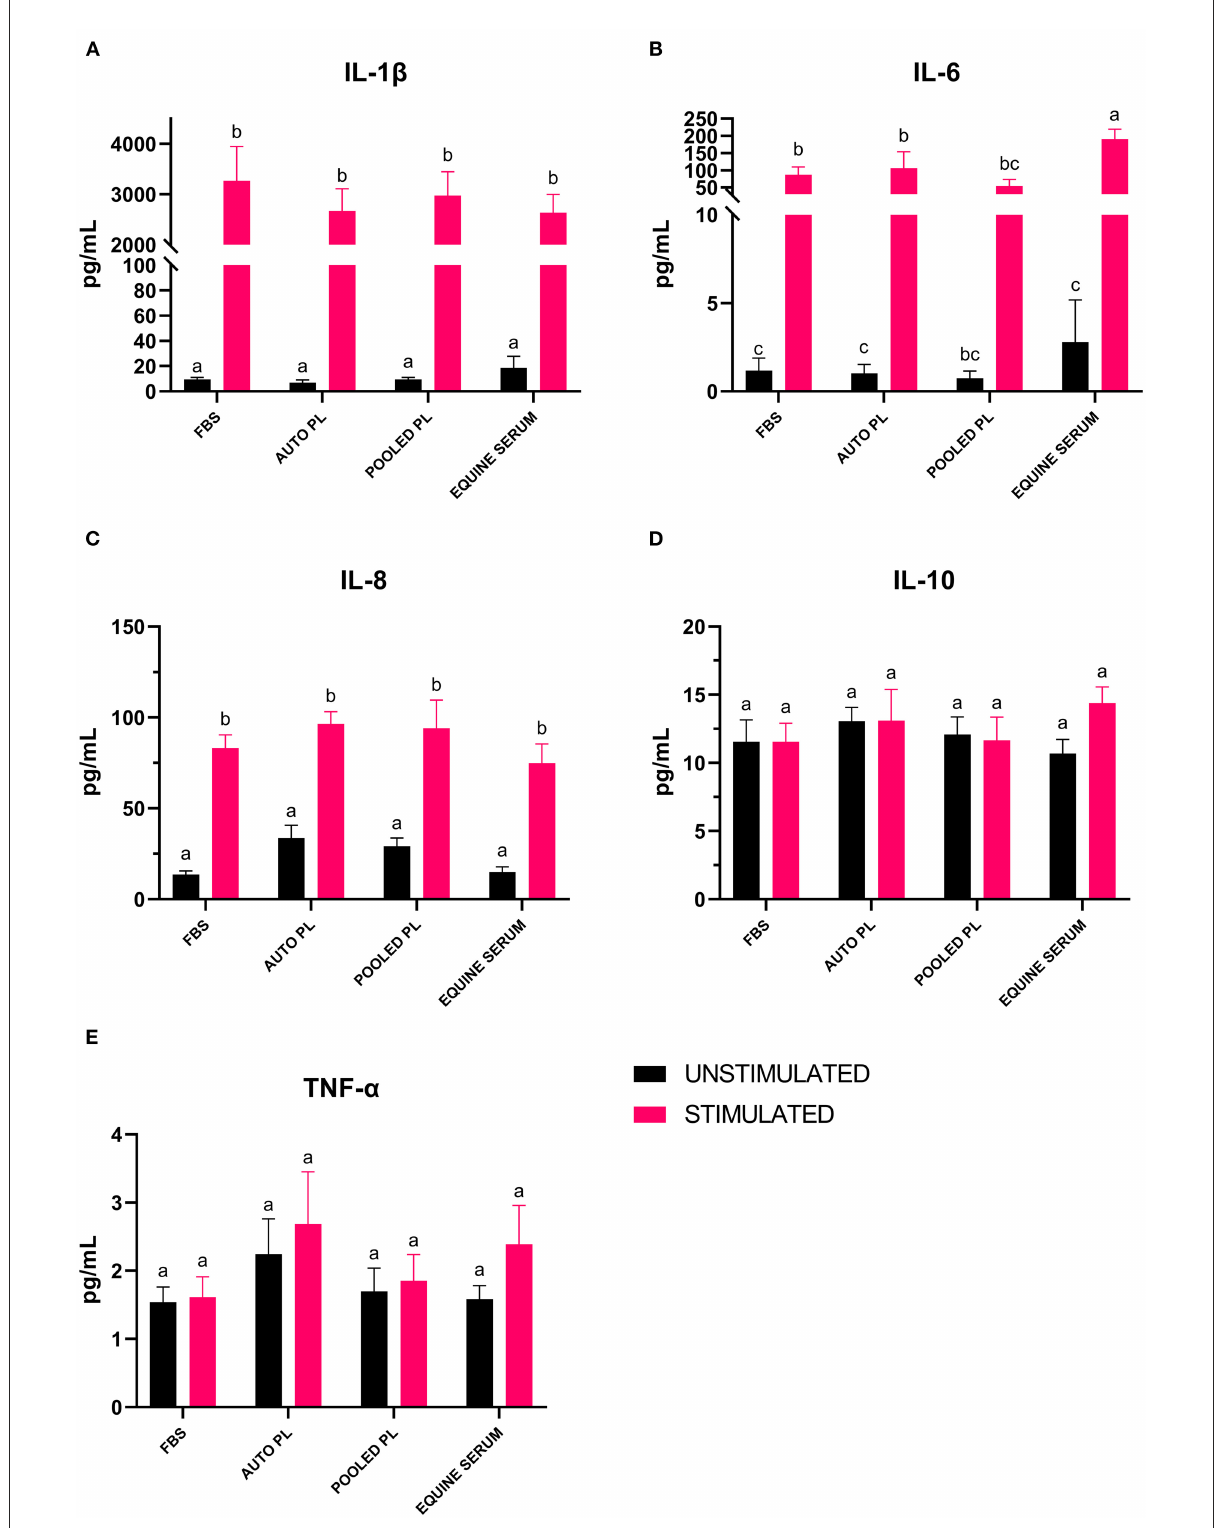
FIGURE5 Mean ( ± SEM) concentration of (A) IL-1 β , (B) IL-6, (C) IL-8, (D) IL-10 and (E) TNF- α in cell culture supernatants of BM-MSCs cultured in four different media types with (stimulated) or without (unstimulated) IL-1 β preconditioning. Different letters denote significant differences between groups; p < 0.05 ( n = 6). PL, platelet lysate; EQ, equine; FBS, fetal bovine serum; auto, autologous; pg/mL, picograms per